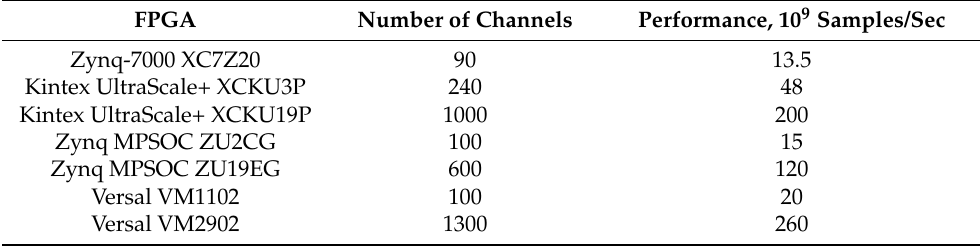
Table 2. Comparative characteristics of FPGA performance when calculating the probability of